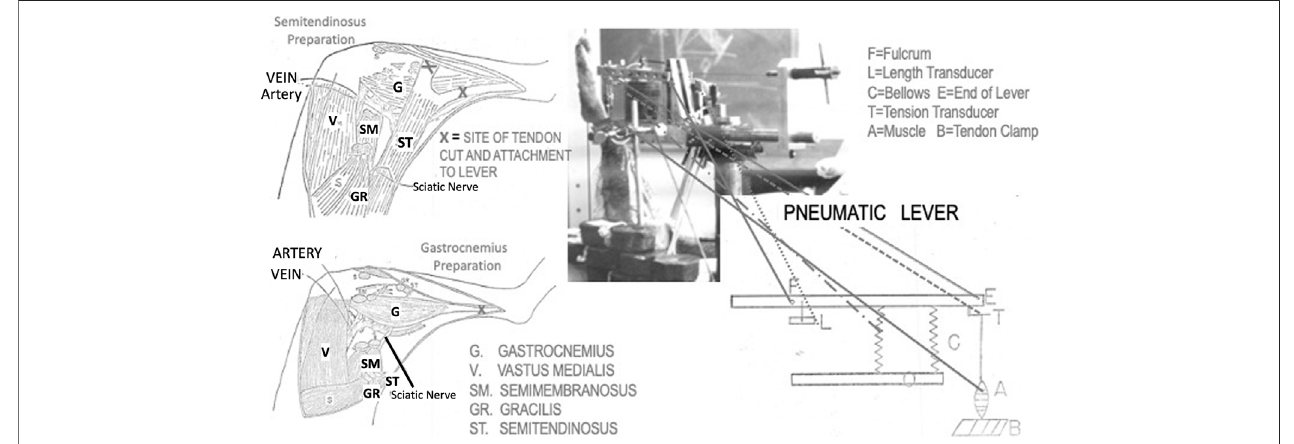
FIGURE1| Artist ’ sdepictionsofthetwomusclepreparationsusedinthisresearchandthepneumaticleverusedtomakethemeasurements.Also,atthetopright there is a photograph of the lever system in use for a semitendinosus preparation.